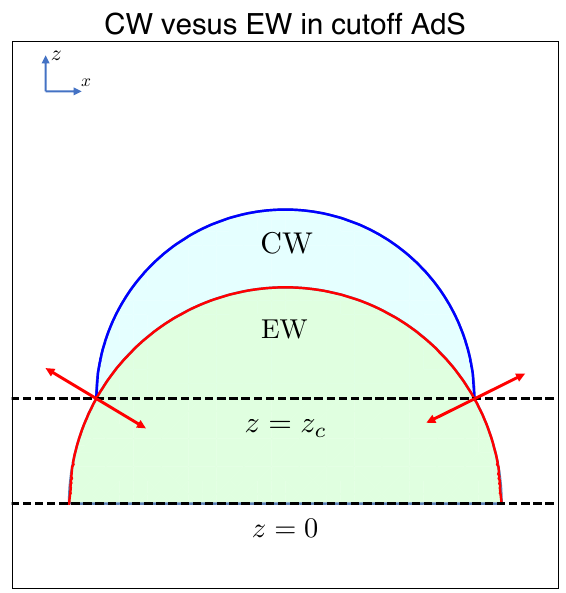
Figure 5 . CW vesus EW in cuto(cid:11) AdS. When we move the boundary from z = 0 to z = z becomes larger than EW. The modular Hamiltonian evolution near the boundary is given by the inward pointing red arrow for R , and points outwardds for (cid:22) R